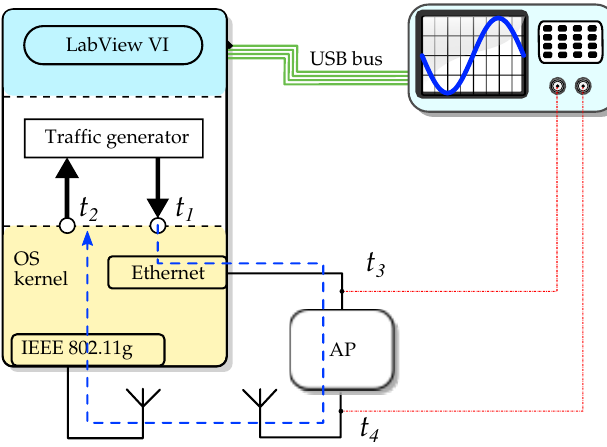
Figure 6. Representation of the designed test-set calibration